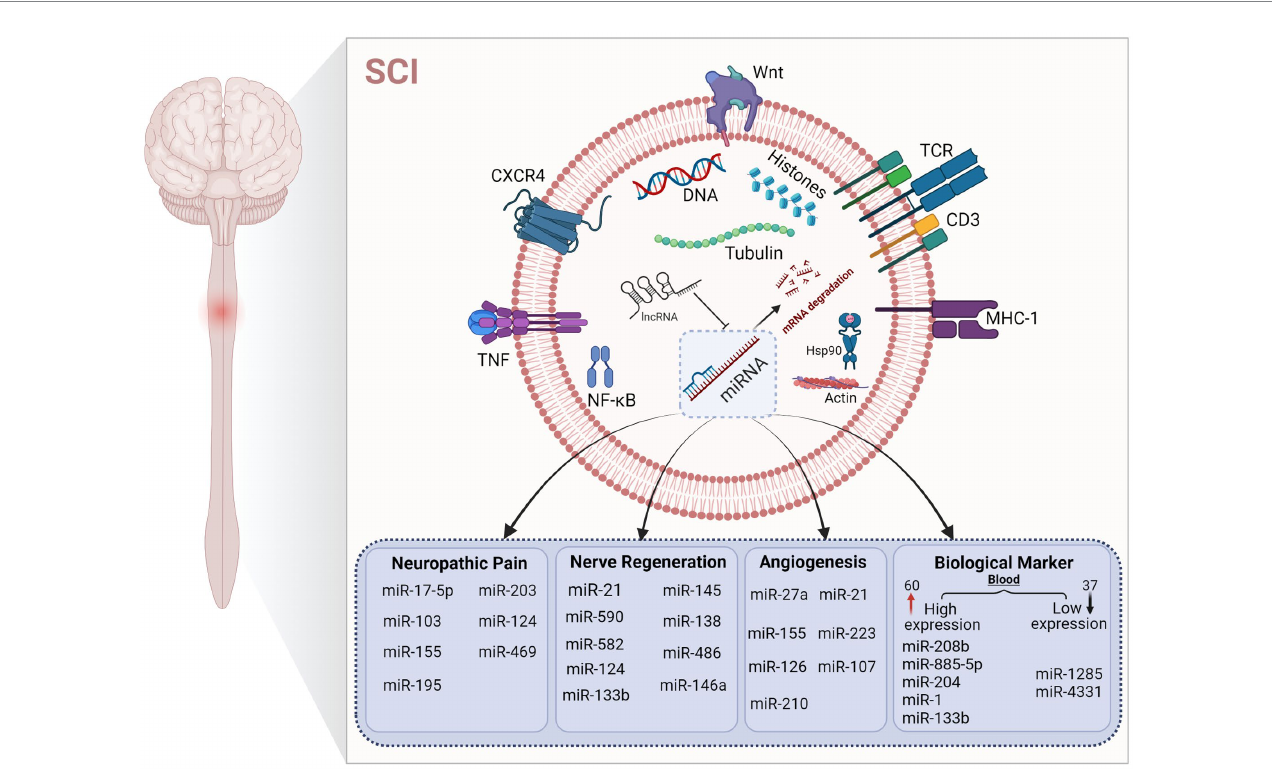
FIGURE 4 Regulation of microRNAs in different mechanisms after SCI. The figure shows that microRNAs play a key role in different pathological states after SCI. The up-regulation and down-regulation of microRNA content affect various pathophysiological processes to varying degrees. Under the regulation of microRNA, mRNA expression is affected, which further affects the expression of corresponding target